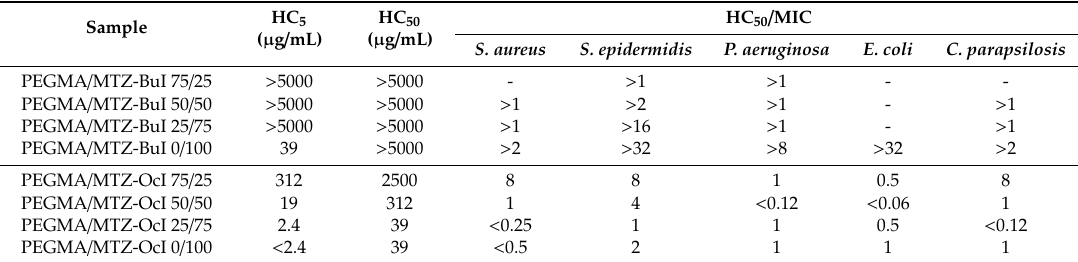
Table 4. Hemolytic activities (HC 50 ) and selectivity values (HC 50 / MIC) obtained for the cationic copolymers P(PEGMA– co –MTZ-BuI) and P(PEGMA– co –MTZ-OcI). HC 5 , hemolysis percentage